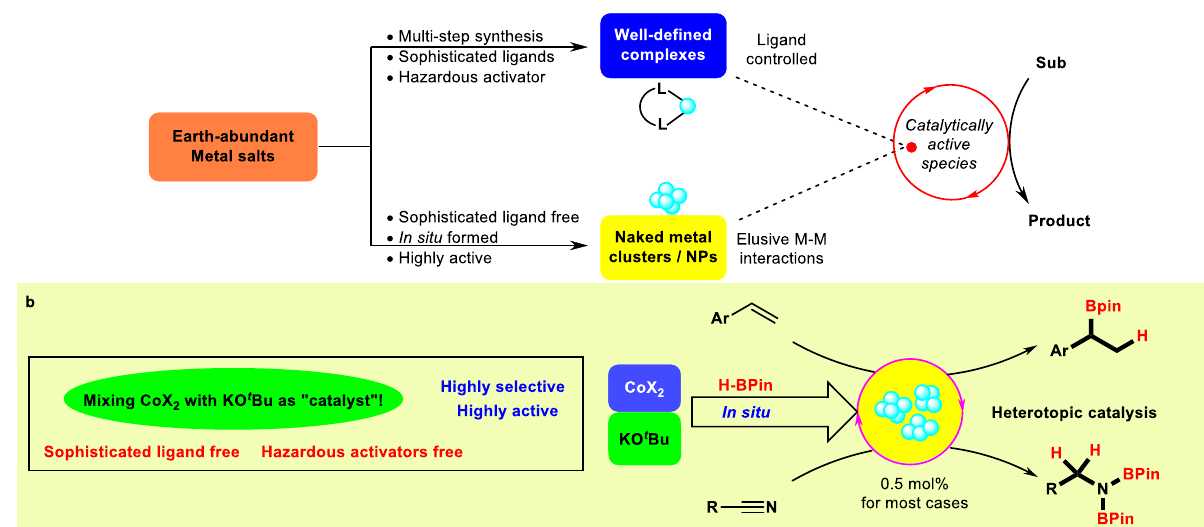
Fig. 1 Earth-abundant metal catalysis in organic synthesis. a Homogenerous earth-abundant metal catalysis in synthetic methodology. b Simple CoX 2 activation by KO t Bu in hydroboration